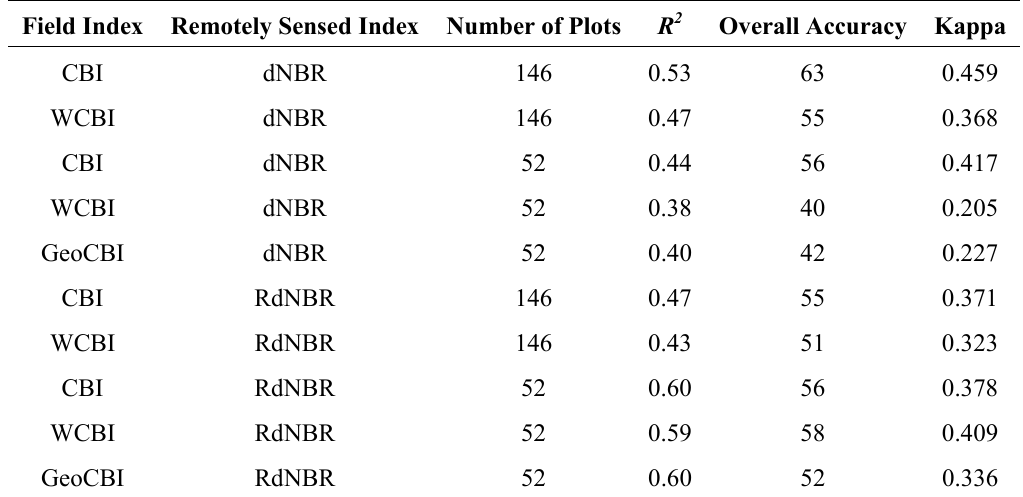
Table 7. Variance explained and overall accuracies for models using CBI, WCBI, and GeoCBI. Field Index